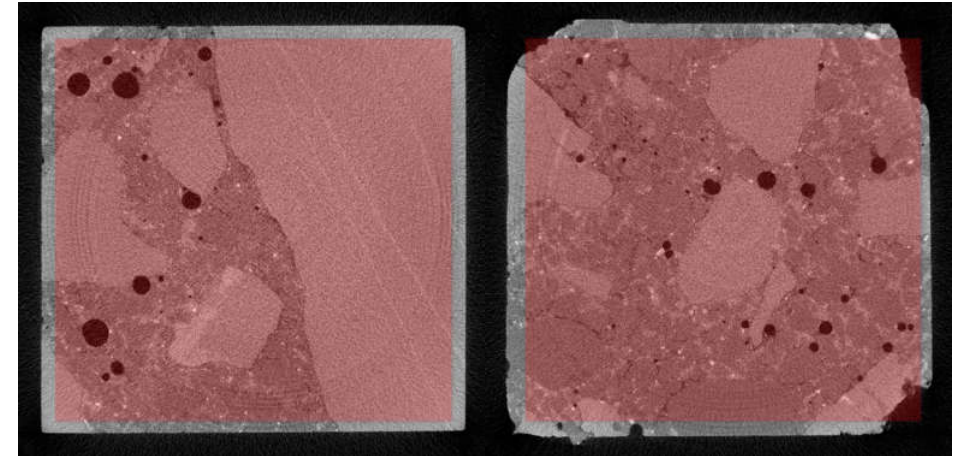
Figure 30. Region of interest (ROI) for selected cross sections.